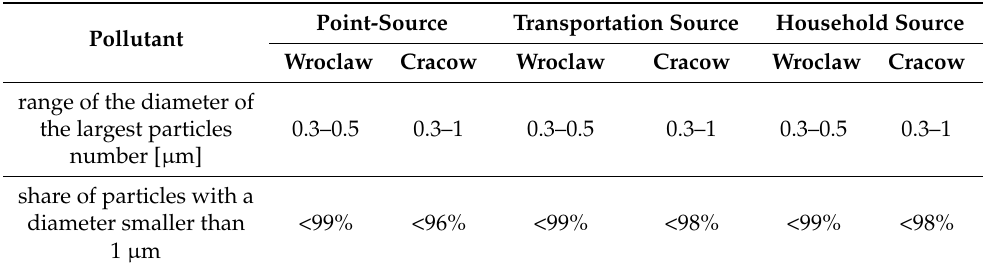
Table 1. Detailed results of PN distribution in Wroclaw and